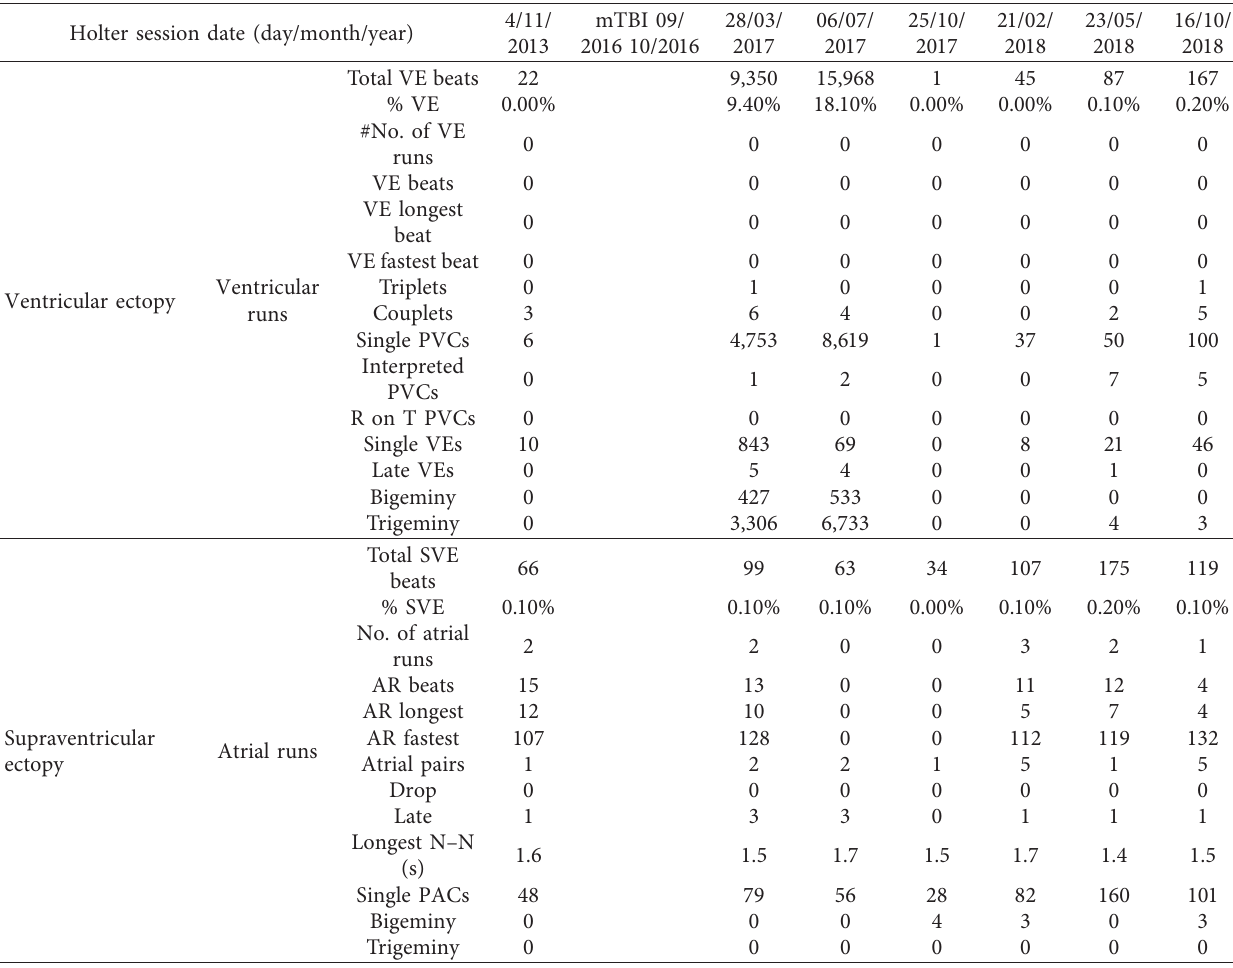
Table 1: Ventricular and supraventricular ectopy data from the 24-hour Holter monitor from April 2013 to October 2018. Holter session date